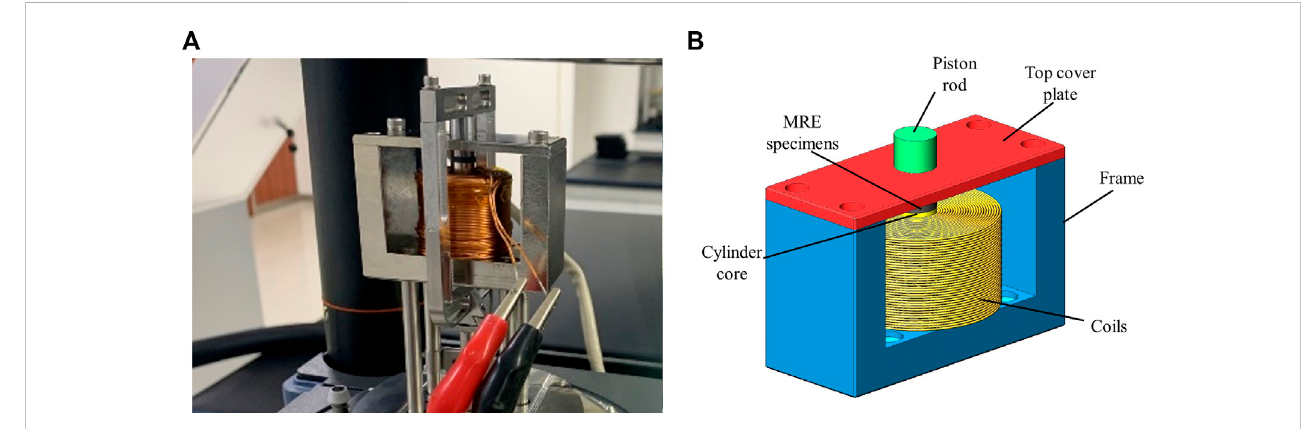
FIGURE 2 DMA measurement (A) and clamps (B) of MRE